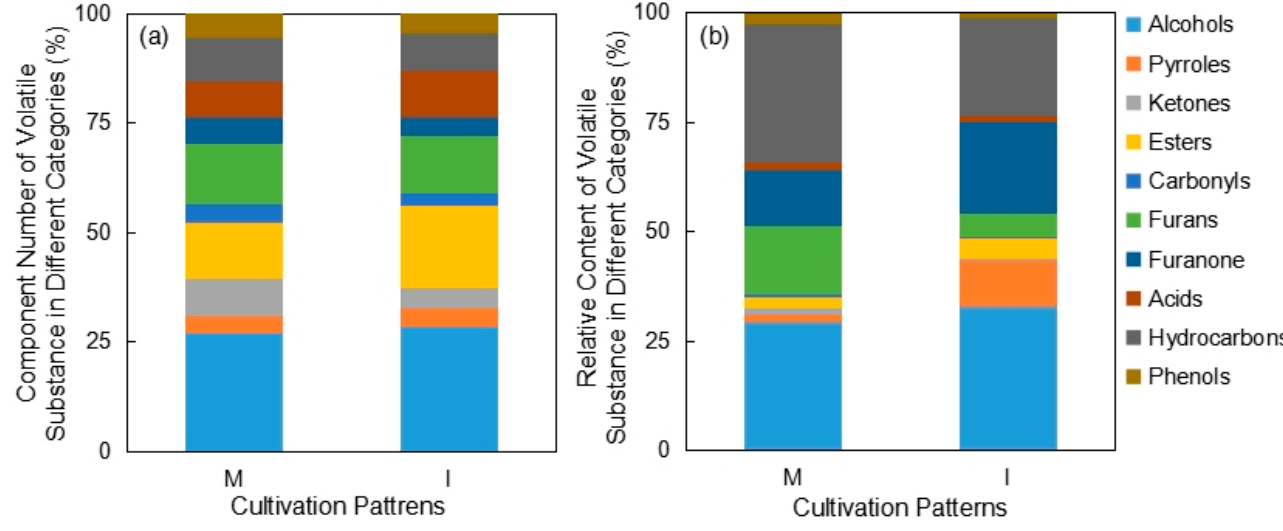
Figure 1. Effects of monoculture and intercropping patterns on the component numbers ( a ) and relative contents ( b ) of volatile substance in different categories. n = 10. M: Pandanus amaryllifolius monoculture, I: Pandanus amaryllifolius and Hevea brasiliensis intercropping.